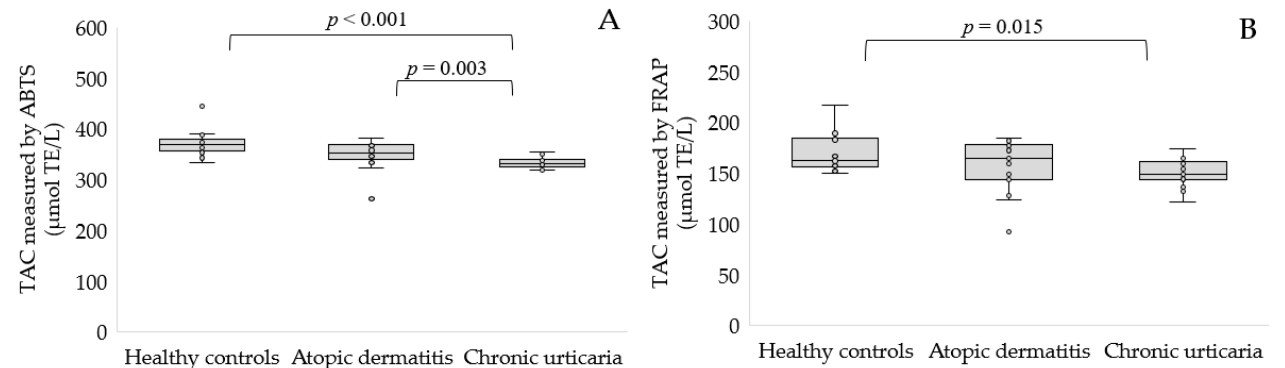
Figure 2. TAC level determined by ABTS • ( A ) and FRAP ( B ) in the serum of patients with AD or CU as compared to the control group.